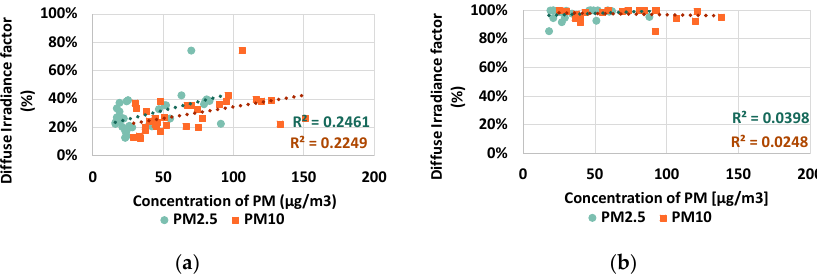
Figure 11. Diffuse irradiance factor based on the concentration of particulate matter (PM): ( a ) clear sky; ( b ) overcast.